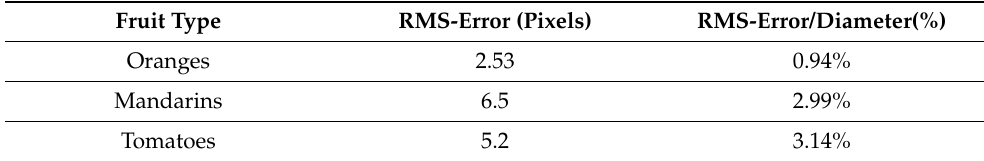
Table 4. RMS reprojection-error for different kinds of